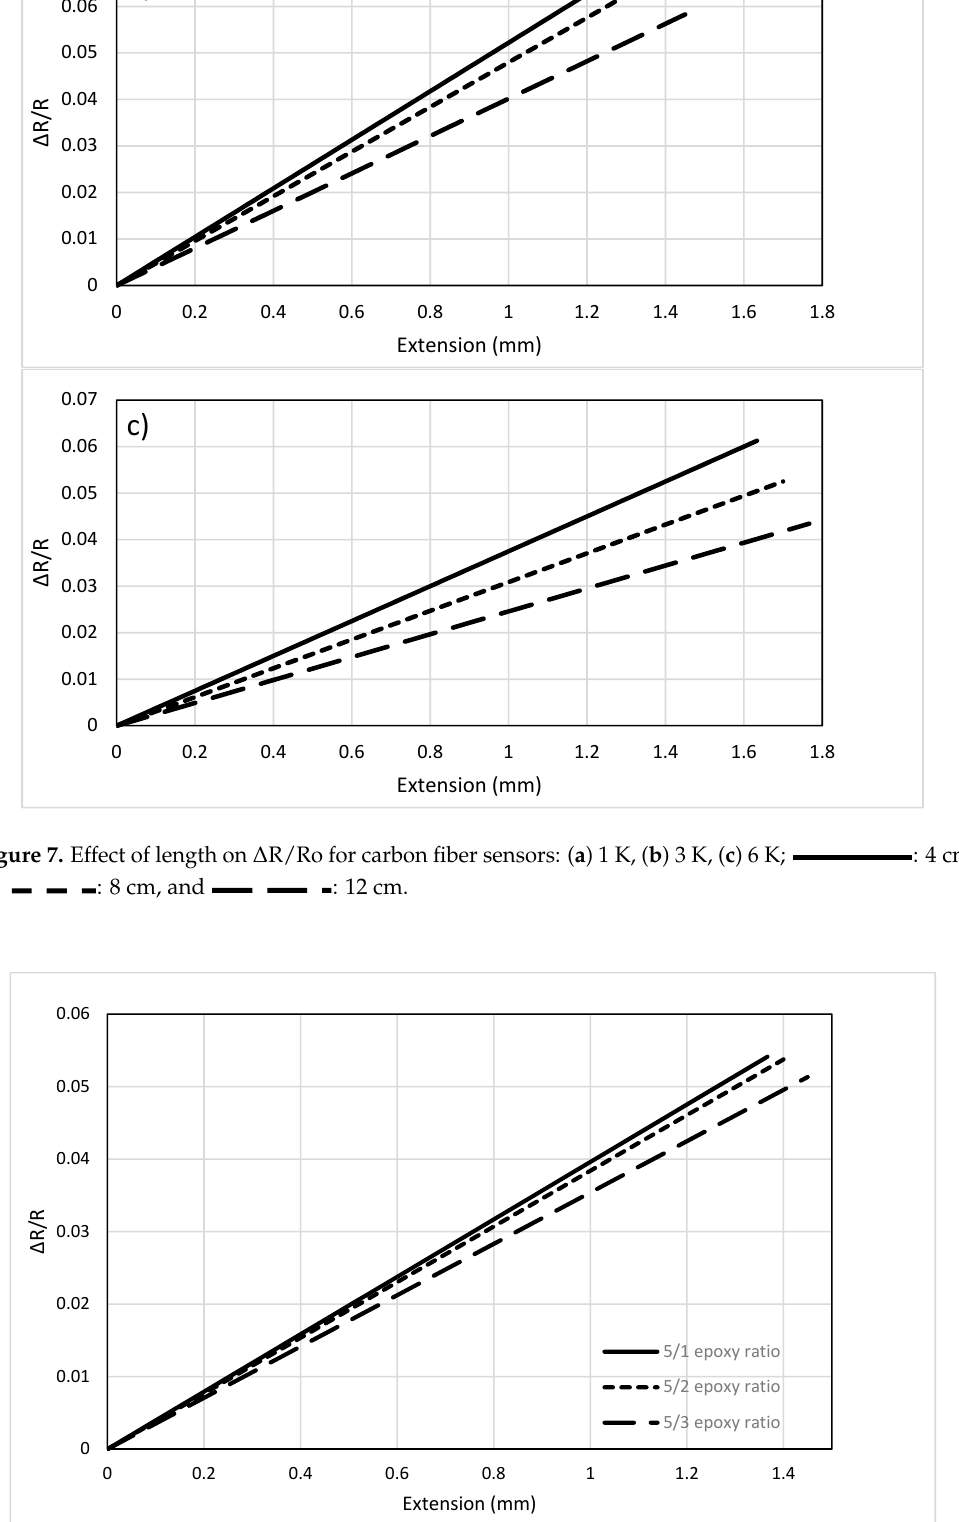
Figure 8. Effect of epoxy treatment on carbon fiber